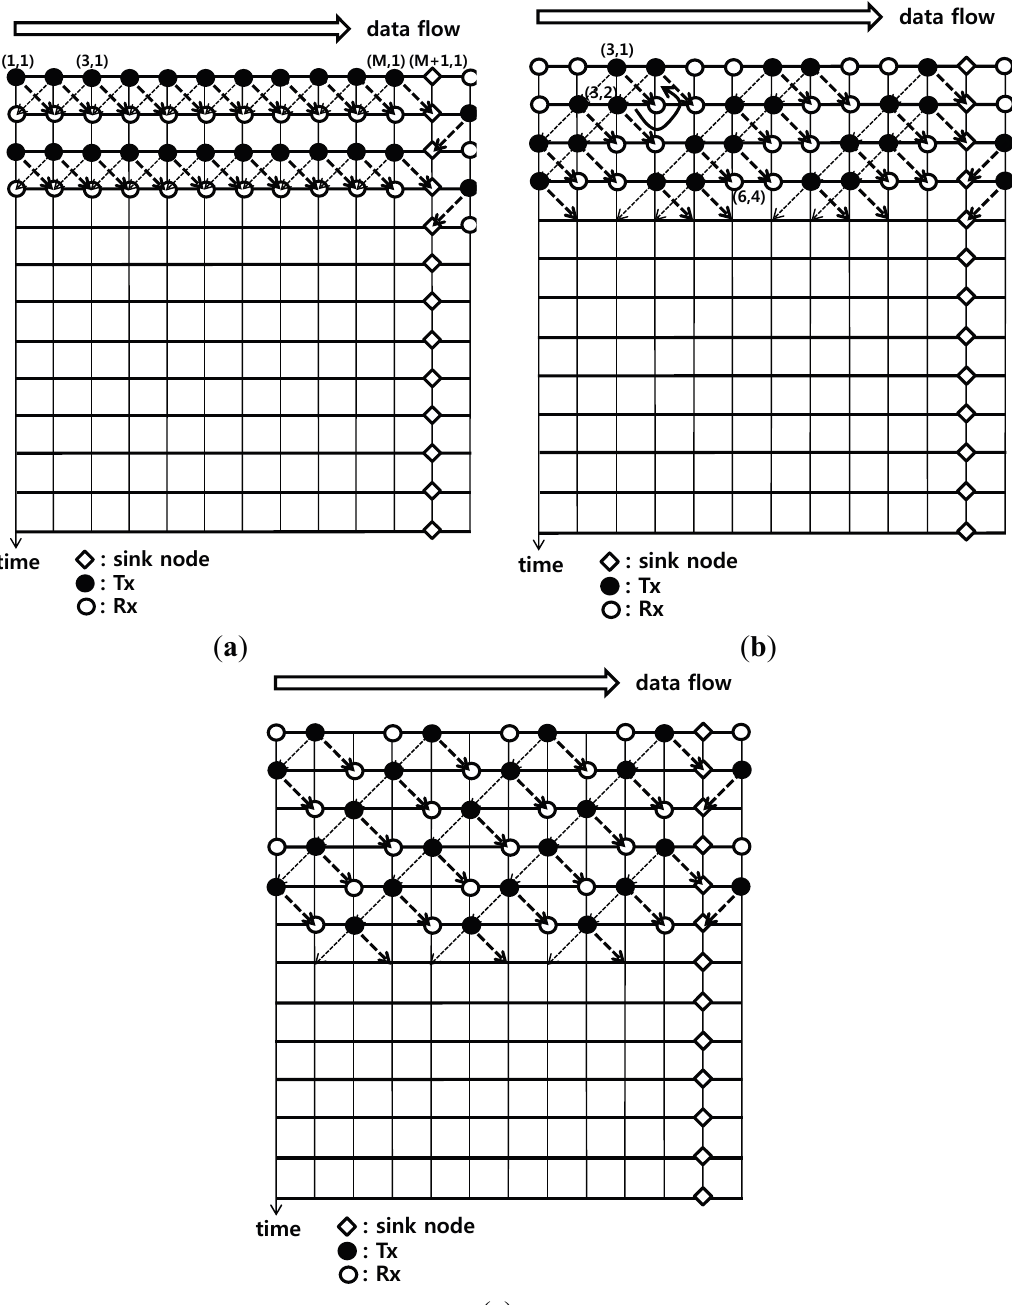
Figure 4. Proposed transmission/reception timing schemes. (The thick arrows represent data transfer) ( a ) Scheme 1; ( b ) Scheme 2; ( c ) Scheme